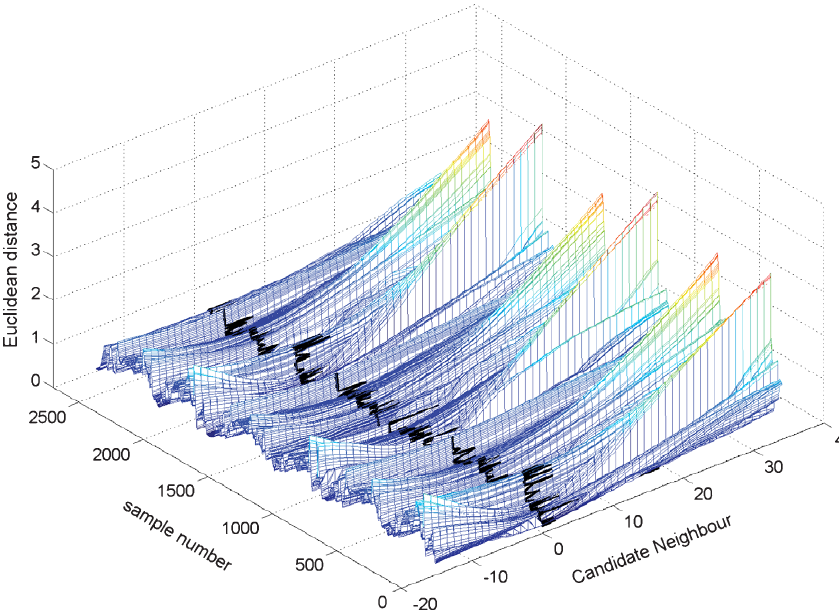
Fig. 7. Calculation of the NN during a stable walking experiment. The surface represents the Euclidean distance to every candidate neighbour at every sample of the trial, the black solid line the